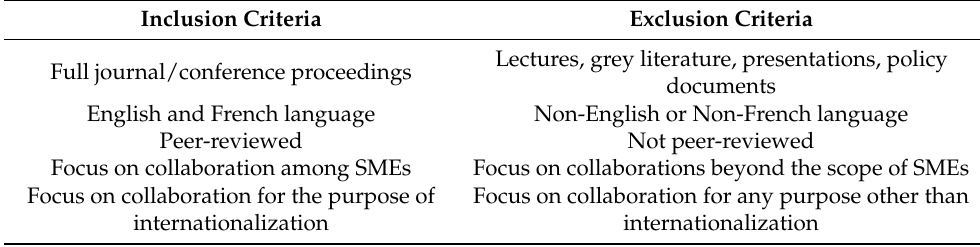
Table 1. Inclusion and exclusion criteria assumed for the literature review.